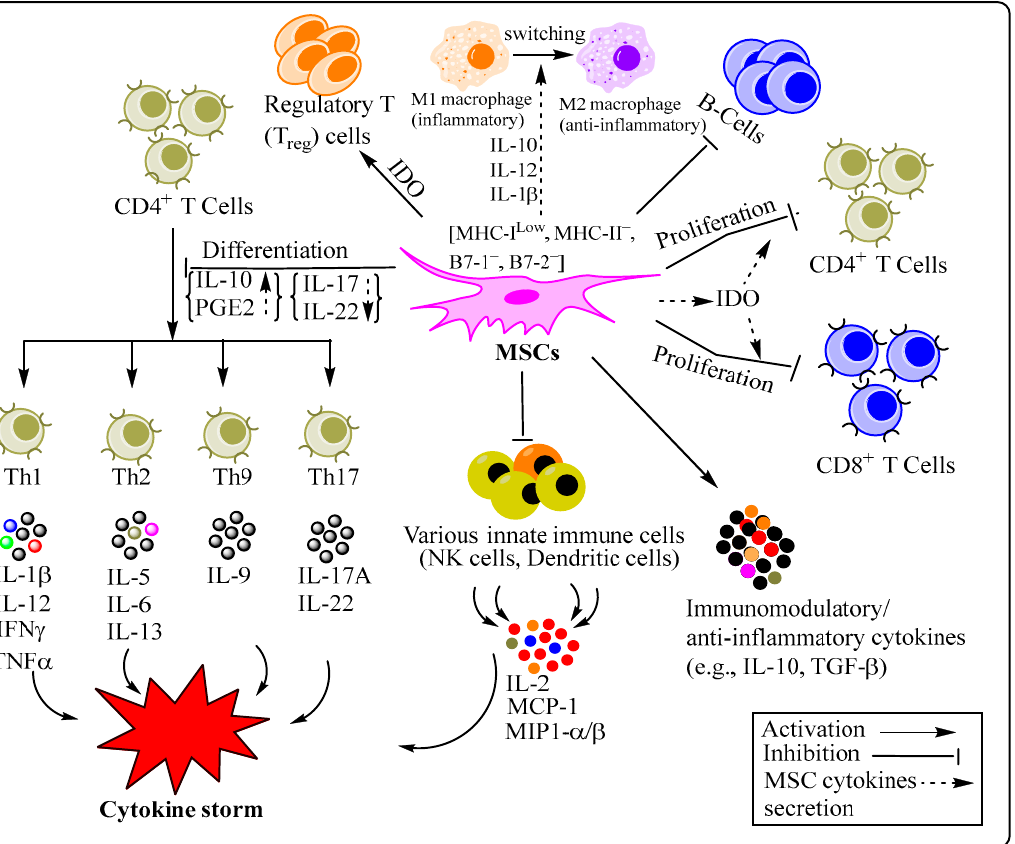
Figure 1. Mesenchymal stem cells (MSCs) accomplish immunomodulation through regulation of various mechanisms (paracrine and juxtacrine signaling) underlying the functioning of diverse innate and adaptive immune cells. Abbreviations: MSCs: Mesenchymal Stem Cells; IL: Interleukin; IFN γ : Interferon gamma; TNF α : Tumor necrosis factor alpha; MCP-1: Monocyte chemoattractant protein-1; MIP1- α / β : Macrophage inflammatory proteins MIP1 α (also referred as CCL3) and MIP2 α (also referred CXCL2), indoleamine 2, 3-dioxygenase (IDO); PGE2: Prostaglandin E2; TGF- β : Transforming growth factor- β ; MHC: Major histocompatibility complex.